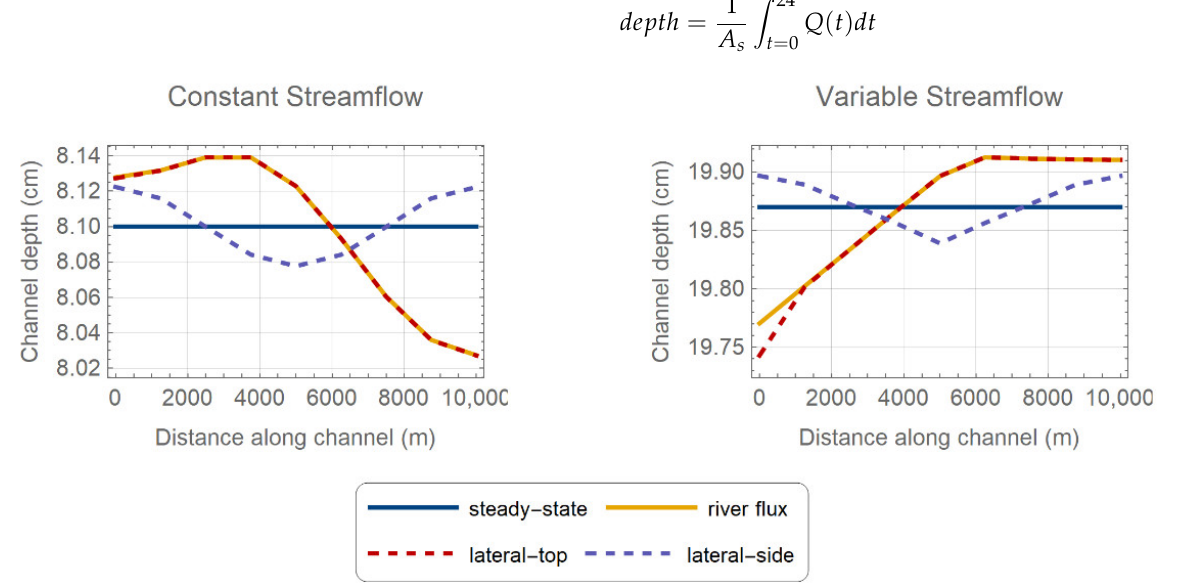
Figure 4. Model results compared to the steady state water depths with constant lateral inflows and river flux boundaries and with variable lateral inflows and river flux boundaries. Note that a distance of zero corresponds to the top of the channel at node 861.